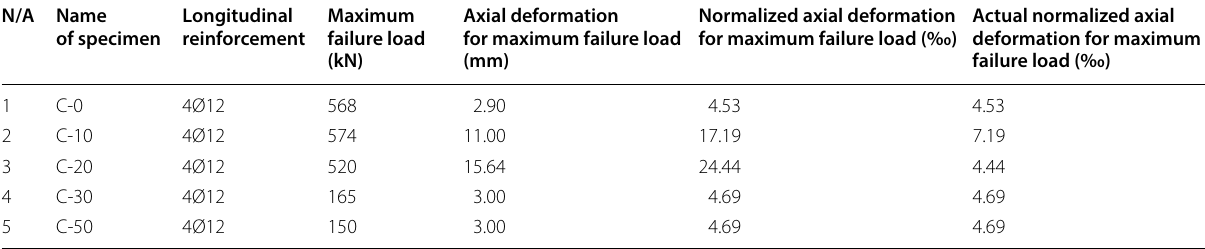
Table 6 Axial deformations for maximum failure load of compression